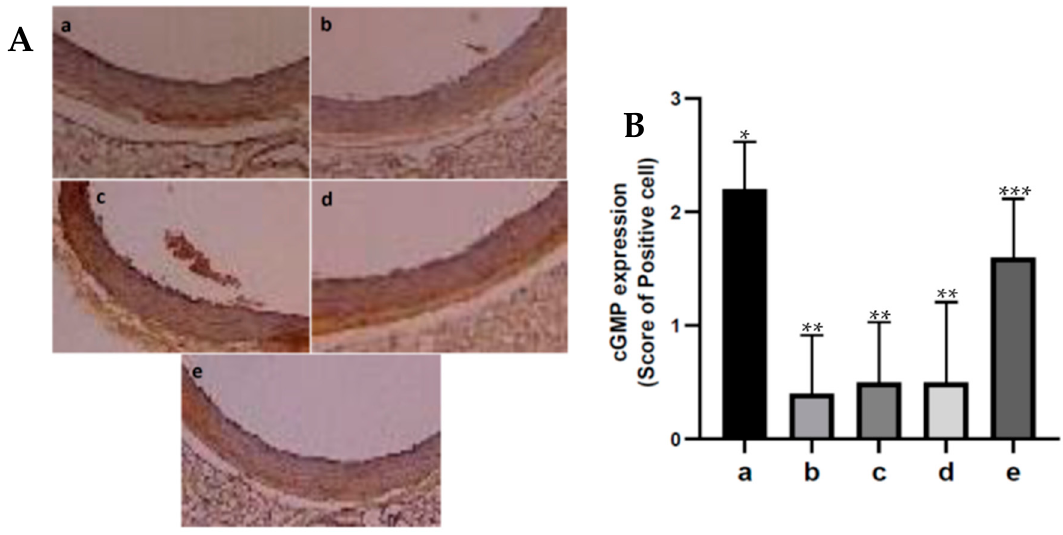
Figure 4. A. Immunohistochemistry of the expression of cGMP in aortic tissue of diabetic rats: control rats ( a ); diabetic rats ( b ); fucoidan nanoparticles at doses of 75 ( c ), 150 ( d ), and 300 mg/kg BW ( e ). (400×.). B. The number of cGMP-expressing cells that are immunoreactive. * - ***The columns with different letters show significance between groups ( p < 0.05).